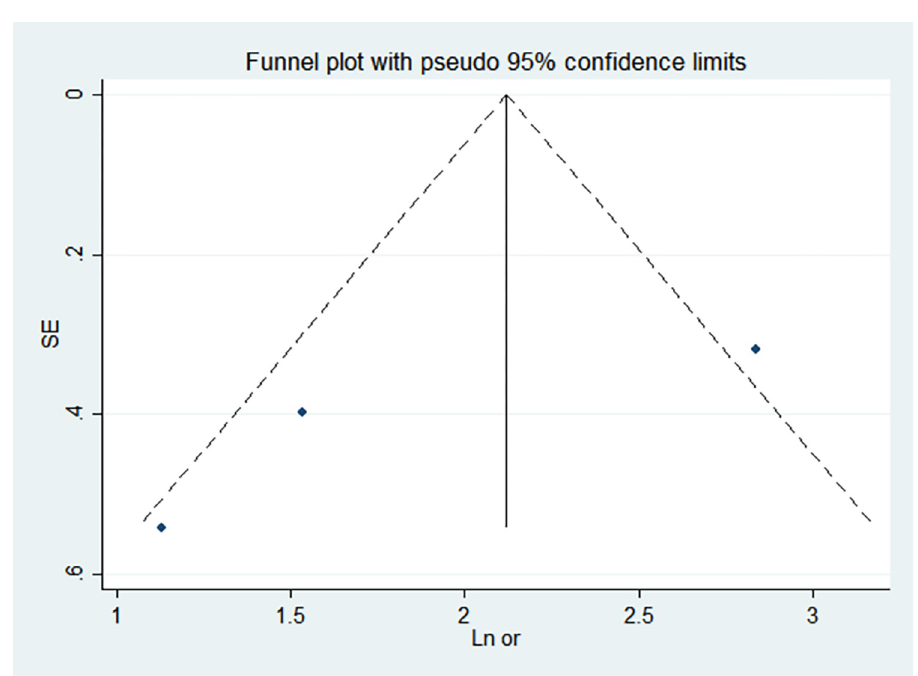
Fig 11. Funnel chart of birth weight <